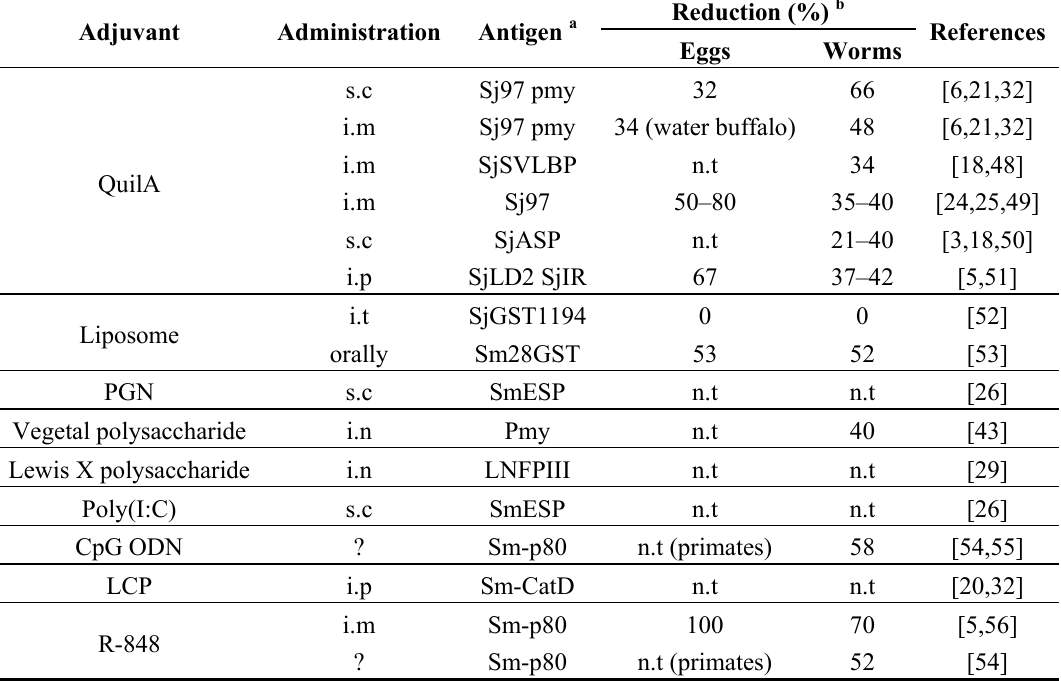
Table 5. Particulate-adjuvanted Schistosoma vaccine candidates classified as a function of the